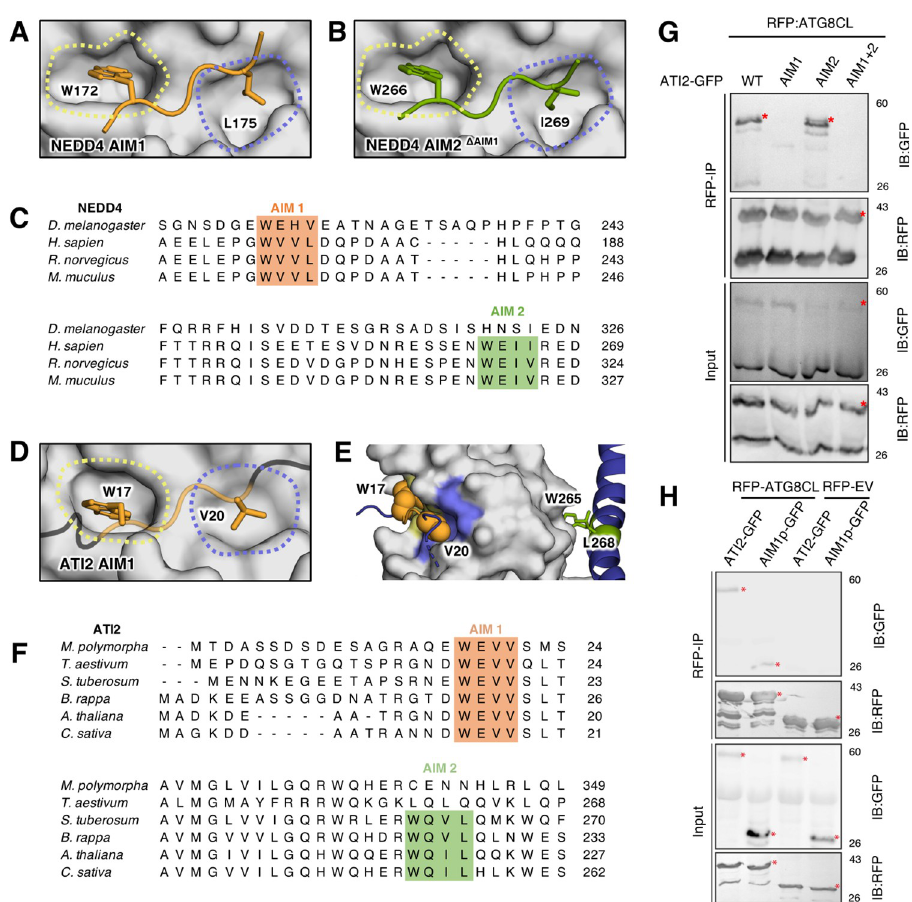
Fig 2. AF2 multimer can correctly identify a functional AIM/LIR among various targets. (A) AF2-multimer predicts AIM1 (172)WxxL(175) of NEDD4 as the interactor for LC3B pockets. (B) Upon the truncation of AIM1, AF2-multimer predicts another interface at (266)WxxI(269), which was identified as AIM2, previously. (C) Two AIMs of NEDD4 are conserved among Drosophila melanogaster , Homo sapiens , Rattus norvegicus , and Mus musculus . (D) ATI2 contains two-functional AIMs and AF2-multimer predicts the interface at AIM1 (17)WxxV(20) as the functional AIM. (E) AIM2 of ATI2, (265)WxxV(268), is localised in an alpha-helix and a distance away from the LC3B AIM pockets. (F) AIM1 of ATI2 is conserved among Marchantia polymorpha , Triticum aestivum , Solanum tuberosum , Brassica rapa , Arabidopsis thaliana , and Cannabis sativa , whereas AIM2 is not conserved in M . polymorpha and T . aestivum . AIM1 and AIM2 for both NEDD4 and ATI2 have been coloured as orange and green, respectively. (G) In planta co-immunoprecipitation between ATG8CL and ATI2 and its mutants (ATI2AIM1, ATI2AIM2, or ATI2AIM1 +2). RFP-ATG8CL was transiently co-expressed with either ATI2-GFP, ATI2 AIM1 GFP, ATI2 AIM2 -GFP, or ATI2 AIM1 +2 -GFP. Red asterisks indicate expected band sizes. (H) In planta co-immunoprecipitation between ATG8CL and ATI2 and ATI2 AIM1 peptide. RFP-ATG8CL or RFP-EV control was transiently co-expressed with either ATI2-GFP or ATI2 AIM1p-GFP. Red asterisks indicate expected band sizes. Data are available in S1 Data. Models coloured based on AF2-multimer prediction confidence are available in S2 Fig. AF2-multimer prediction files are available from https://doi.org/10.6084/m9.figshare.21533769.v1. Raw images of this figure are provided in S1 Raw images. AF2, AlphaFold2; AIM/LIR, ATG8/LC3 interacting